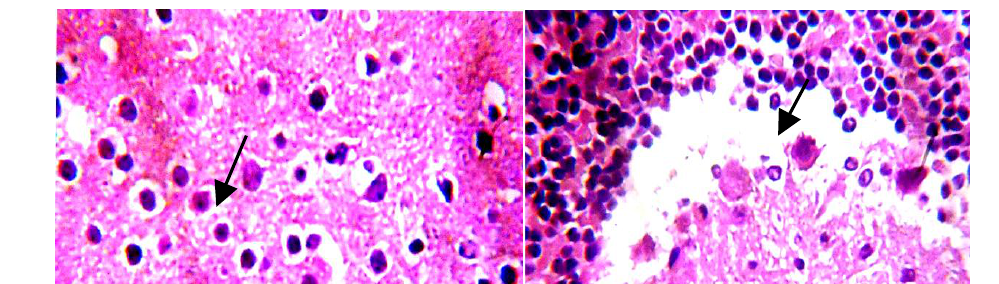
Fig:5 Histopathological section in Brain of T1, Fig:6 Histopathological section in Brain of T1, show extracellular edema characterized by show increase of astrocyte and oligodendrocyte, dilation of Virchow-Robbin space( ) (H&E stain. with edema in granular layer( ) and congestion 40 X) of B.Vs in choroid plexis ( ) (H&E stain. 40 X)